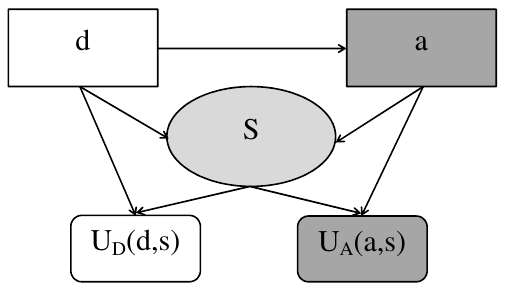
Figure 13. Multi-Agent Influence Diagram (MAID) for the adversarial risk analysis (ARA) defend- attack model.